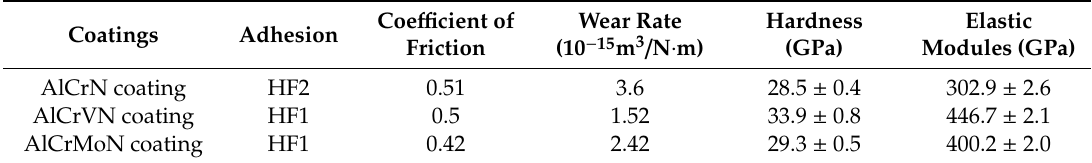
Figure 3. Rockwell morphologies of the coatings on coated HSS substrates ( a ) AlCrN coating, ( b ) AlCrVN coating, and ( c ) AlCrMoN coating.